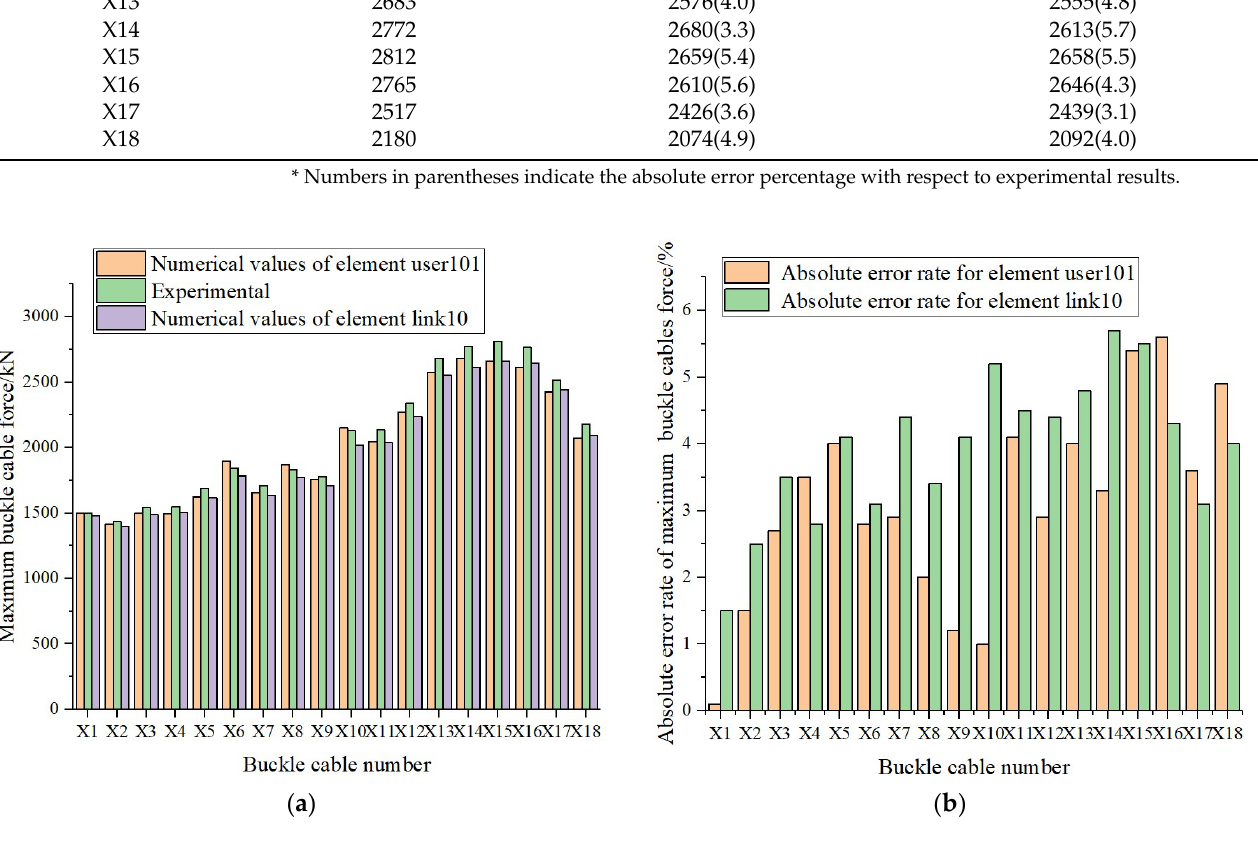
Figure 12. Comparison of maximum buckle force values: ( a ) Comparison of different elements with experimental values; ( b ) Comparison of the absolute error of different elements